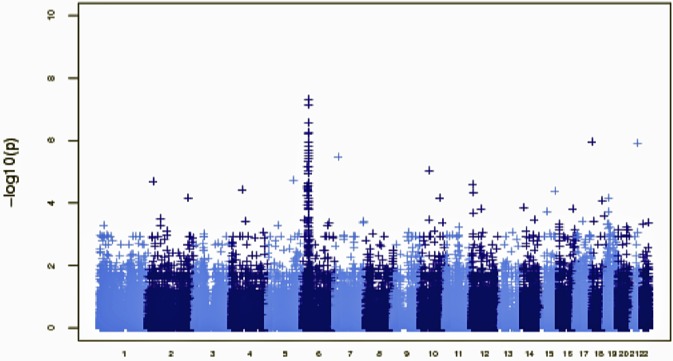
Manhattan plot of single-SNP tests comparing case data (n = 41, one case per multiply affected family) with 220 control samples.